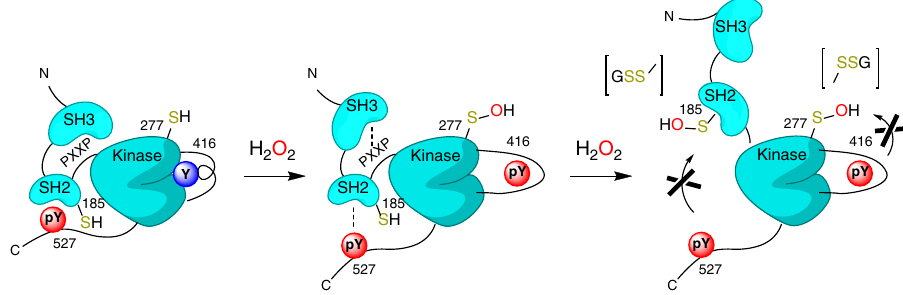
Fig. 6 Concerted roles of Cys-185 and Cys-277 oxidation induces structural changes that contribute to the activation of Src activity. Initially, the solvent exposed Cys-277 is oxidized to sulfenic acid inducing A-loop unfolding and semi- “ unclamping ” of the autoinhibited Src structure (middle). The resulting weakened SH2 and c-terminal tail binding enables oxidation of Cys-185 from solvent H 2 O 2 leading to the full activation of Src (right). It is expected that Cys-185 and Cys-277 sulfenic acids eventually become S- glutathionylated, which permanently obstruct the refolding of Src into the autoinhibited state thereby extending kinase